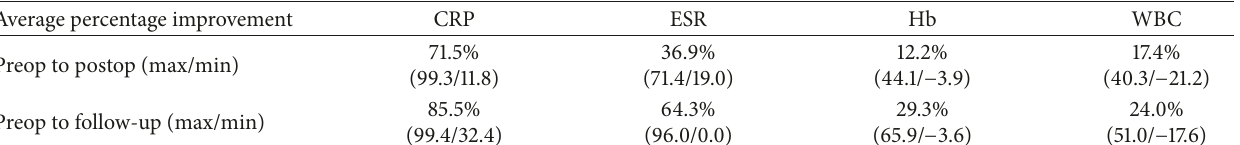
Table 3: Percentage difference between preop to postop values and preop to follow-up values.